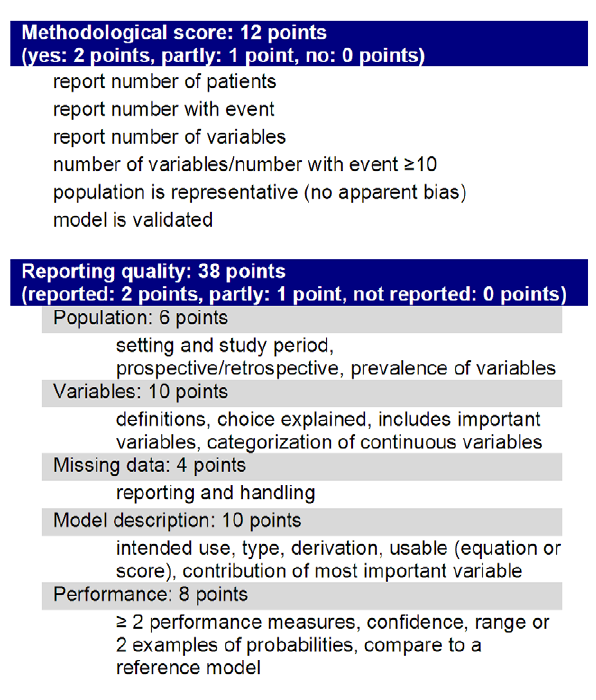
Figure 3. Summary of framework for assessing the quality of studies reporting on the development of a new prediction model. The quality framework consists of two parts, a methodological score with minimal criteria and a reporting score. The complete framework is available in the supporting text S1, along with an assessment of each included